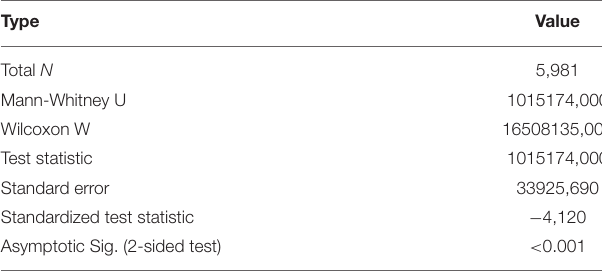
TABLE 2 | Independent-samples Mann–Whitney U test Summary: the length of sick leave related to mental disorder caused by drugs (alcohol, tobacco, illicit